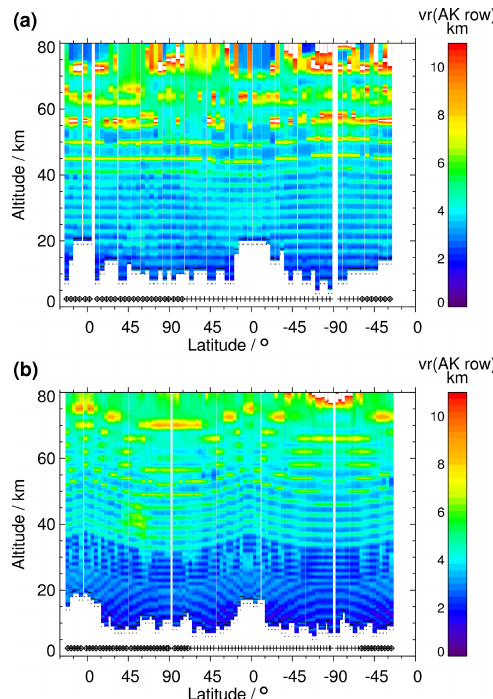
Figure 4. Vertical resolution calculated from the rows of the averag- ing kernel matrix for ozone profiles recorded during the FR (a) and RR (b) measurement period. Data for orbits 4577 (a) and 35800 (b) are shown. The symbols just above the latitude axis indicate the position of the measurement and give the illumination conditions (diamond: night; plus: